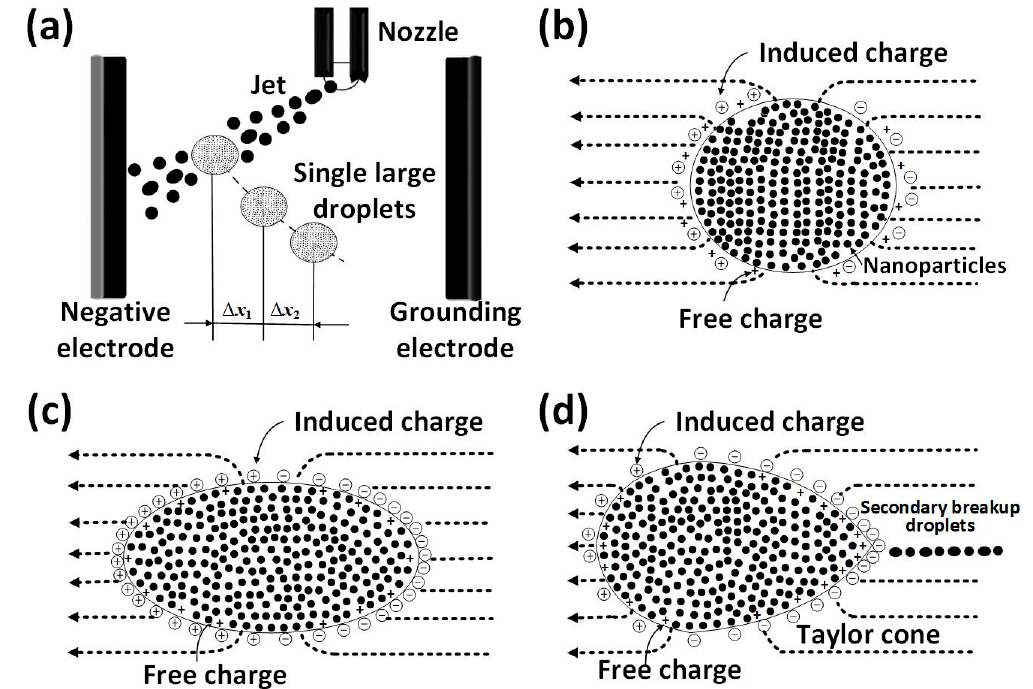
Figure 7. Mechanism of the secondary breakup of an individual electrified nanofluid fuel droplet in uniform electrostatic field, ( a ) production and movement of single droplets, ( b ) initial single spheroidal droplet with uniform charge distribution, ( c ) charge transfer and droplet deformation, ( d ) formation of Taylor cone and secondary breakup.